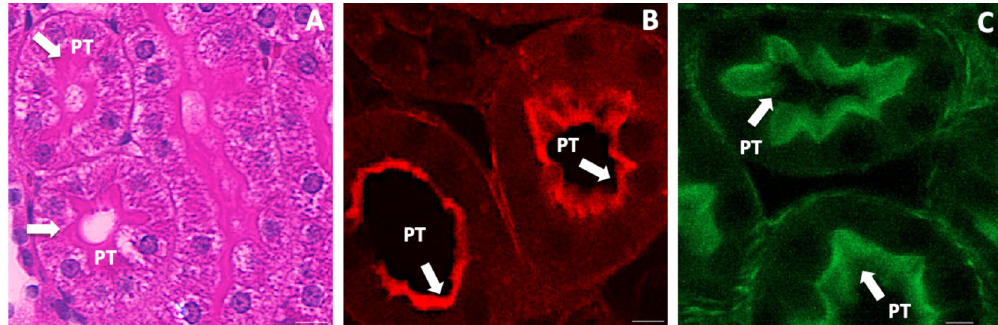
Figure 1. Brightfield and confocal microscopic images highlight the presence of actin in the renal brush border ex vivo. Images were taken with 60× objectives (2× digital zoom) using brightfield ( A ) and confocal ( B , C ) microscopes. These images of the proximal tubule (PT) in cortical kidney sections outline the innate actin localization (identified by arrows) along brush borders using exogenous probes (H&E, A , and Texas-red phalloidin, B ). Similarly, ( C ) highlights the intense presence of actin along the brush border in the PT of cortical kidney sections obtained from rats that expressed EGFP-actin fusion proteins using HGD. ( B ) was taken using only the red-pseudo-color channel, and ( C ) was taken using only the green-pseudo-color channel. Scale bars represent 10